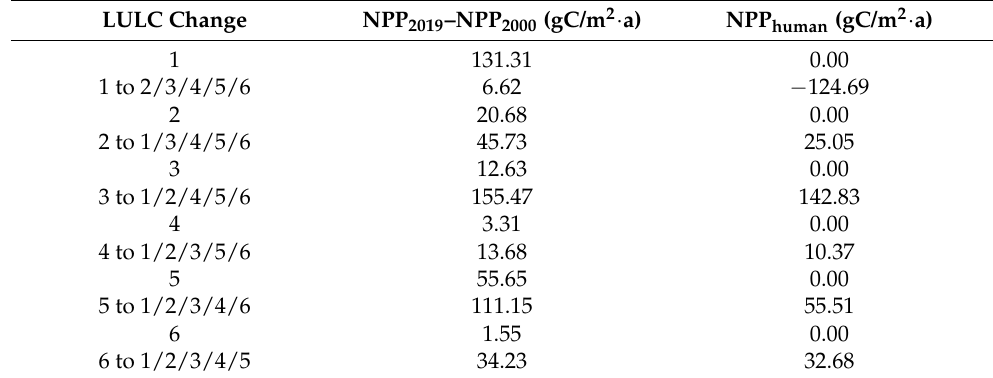
Table 3. Variation in NPP associated with LULC changes in Xinjiang.